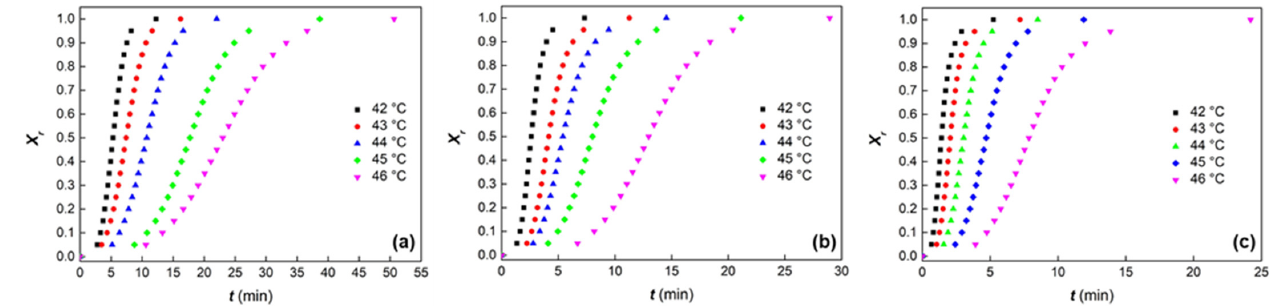
Figure 2. Relative crystallinity as a function of time for PCL ( a ), PCL-HGM10 ( b ), and PCL-HGMf10 ( c ) under isothermal conditions at different T c .